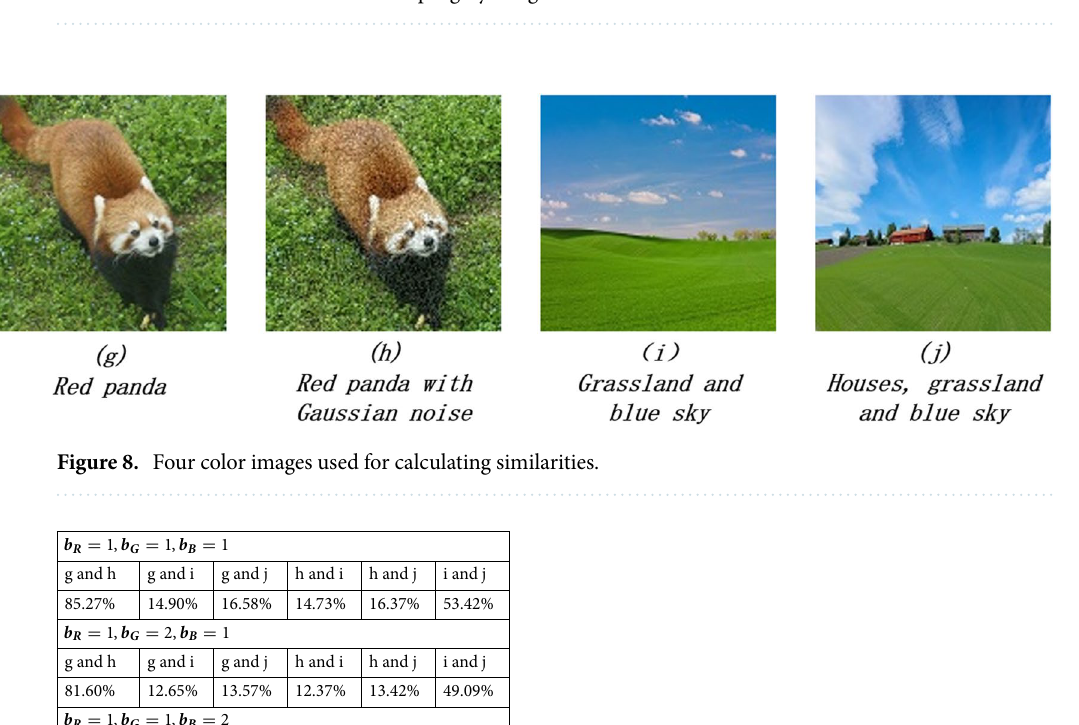
Table 3. Similarities between three sample grey images.